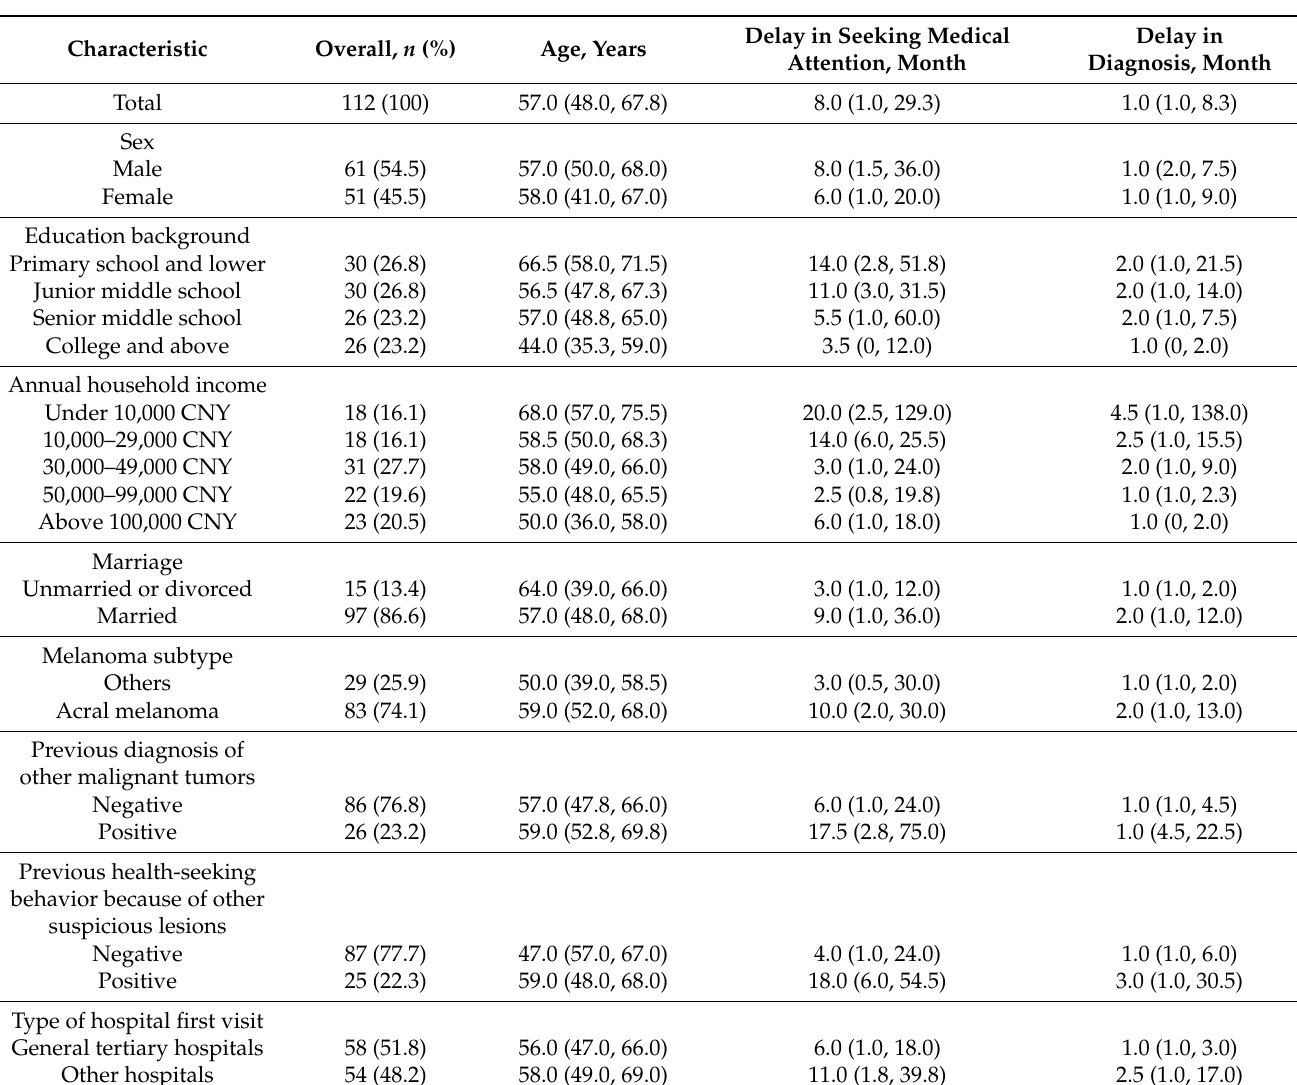
Table 1. Patient